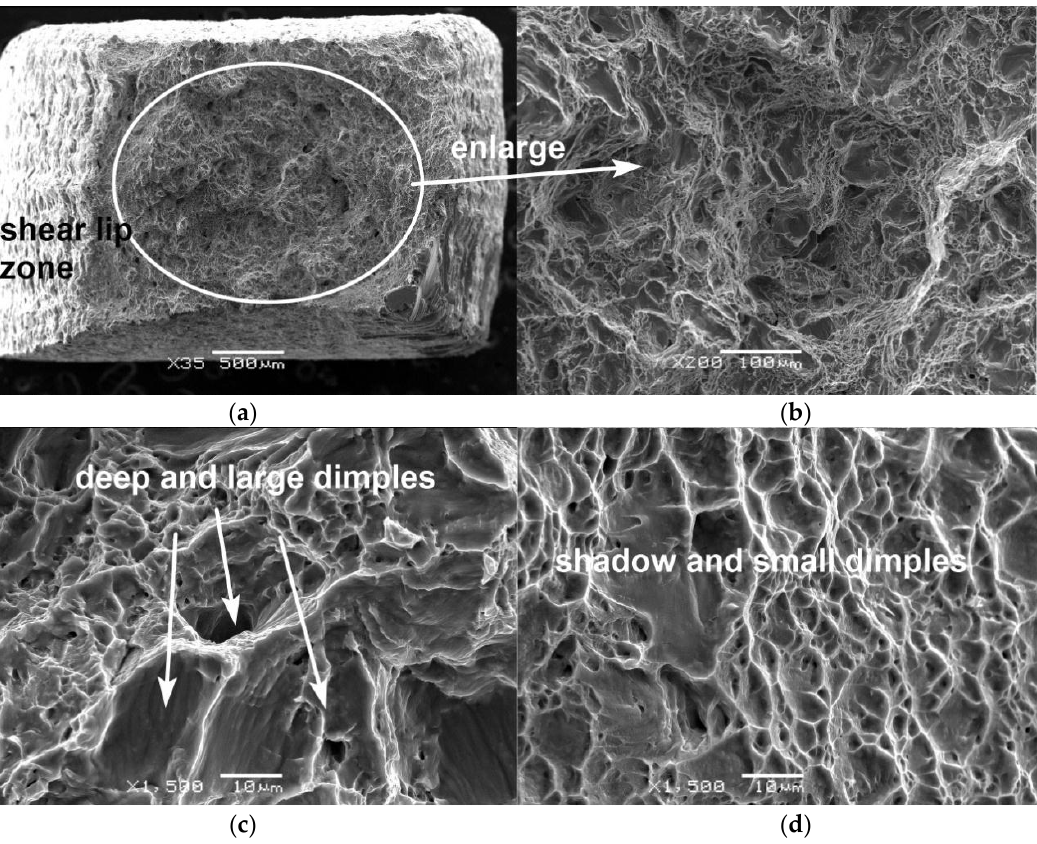
Figure 16. Micrographs of fractured surfaces of as-received CP-Ti with no prestrain: ( a ) macro view showing necking with microcracks and shear lip zone at the outer area; ( b ) magnified view of crack propagation region from central region in Figure 16a; ( c ) magnified image showing deep and large dimples from central region; ( d ) magnified image showing the shallow dimples at the shear-lip region.